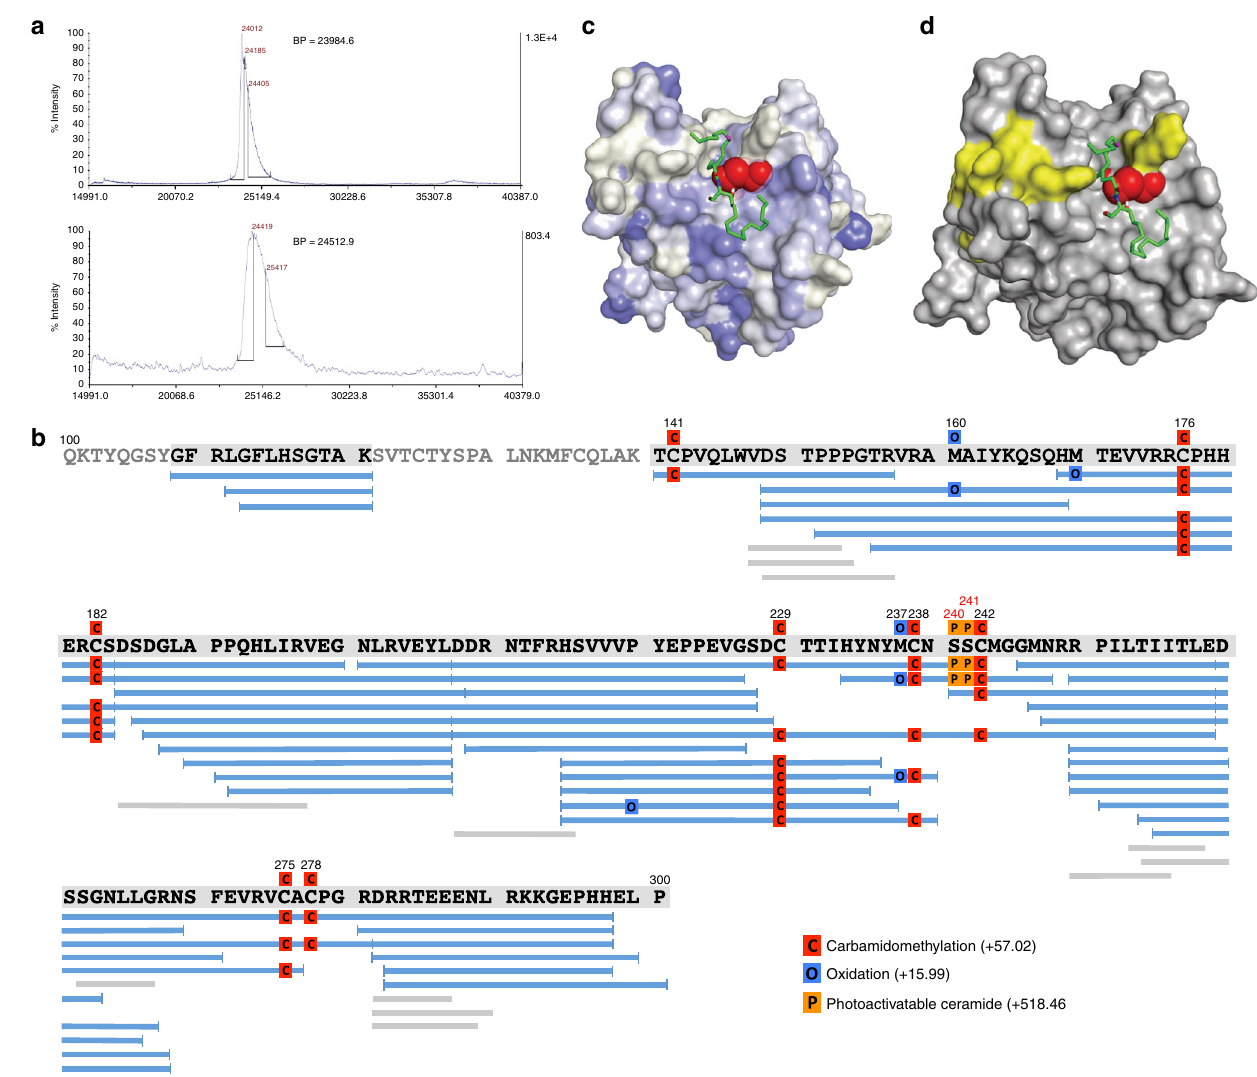
Fig. 3 Binding site of ceramide within the p53 core domain. a MALDI-TOF MS of the control (non-modi fi ed) p53 construct containing residues 100 – 300 (top panel) and the same construct after PAC modi fi cation (bottom panel). Base peaks (BP) differ by 528.3 m / z . b PEAKS analysis of ceramide-modi fi ed p53 100 – 300. Ser-240 and Ser-241 were identi fi ed as modi fi ed (labeled with orange “ P ” , AScore 1000). c Representative conformation of photoactivatable ceramide bound to the p53 construct (pdb 2mej). Hydrophobic surfaces are colored in blue, hydrophilic in white, and Ser240 and Ser241 in red. Photoactivatable ceramide is colored in green with the C10 atom shown in magenta. d Photoactivatable ceramide linked to Ser-240/-241 is in the center of the surface where p53 contacts MDM2 22 (shown in yellow). The p53 surface is colored in gray (pdb